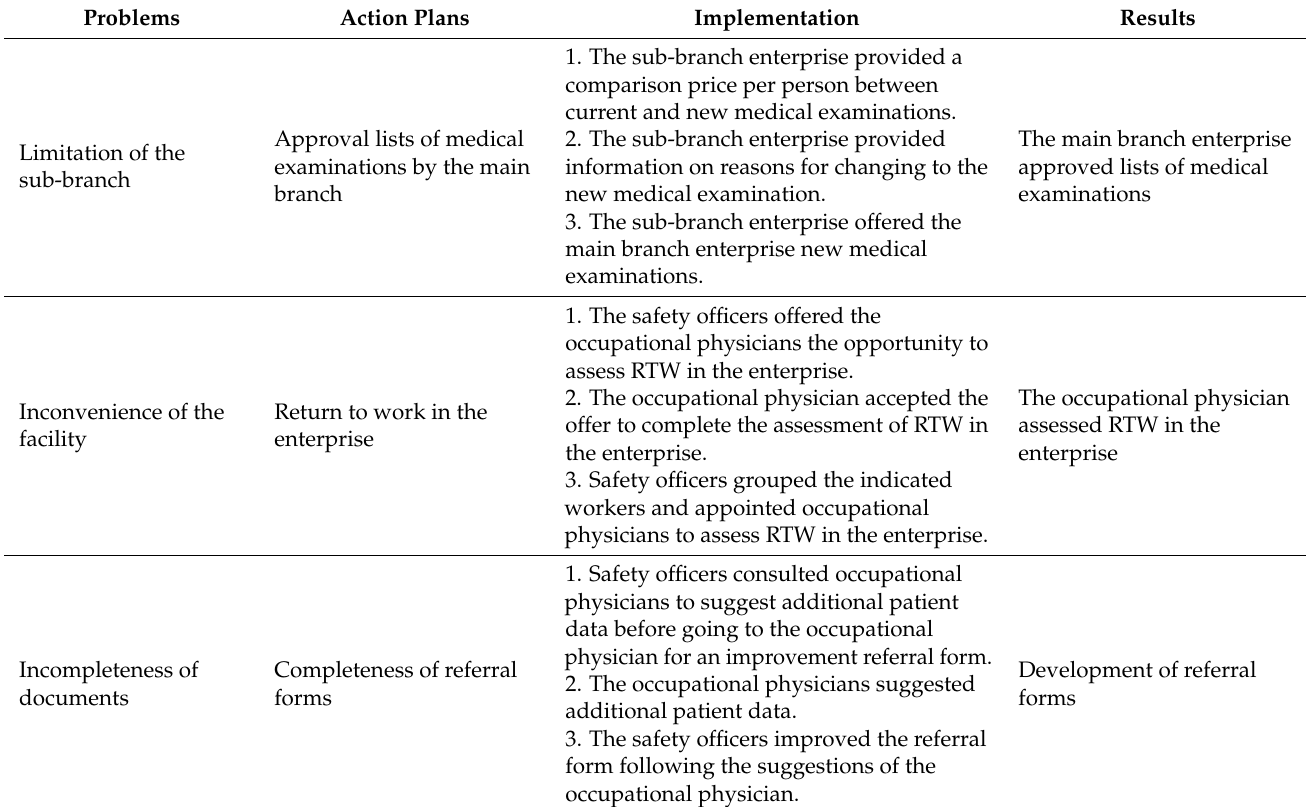
Table 10. Problems, action plans, implementation, and results of loop